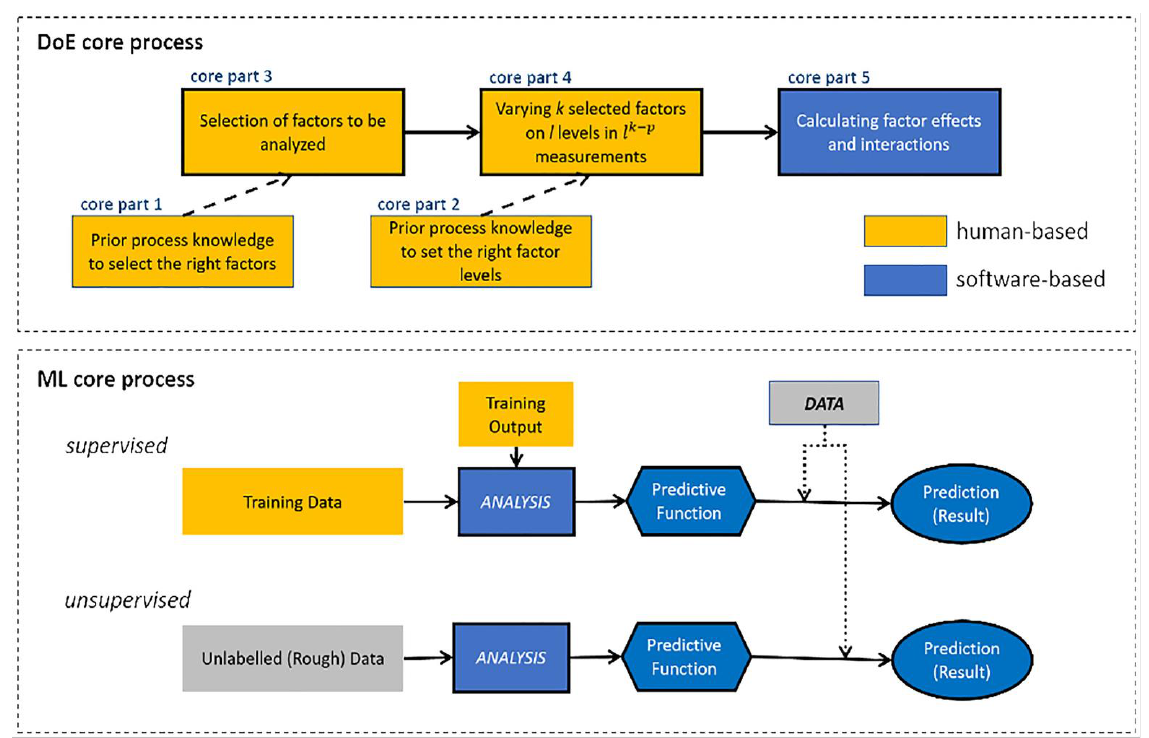
Figure 11. Core processes for the Design of DoE and ML, including human and software-based parts. Reprinted with permission from Ref. [106]. 2019, John Wiley and Sons.